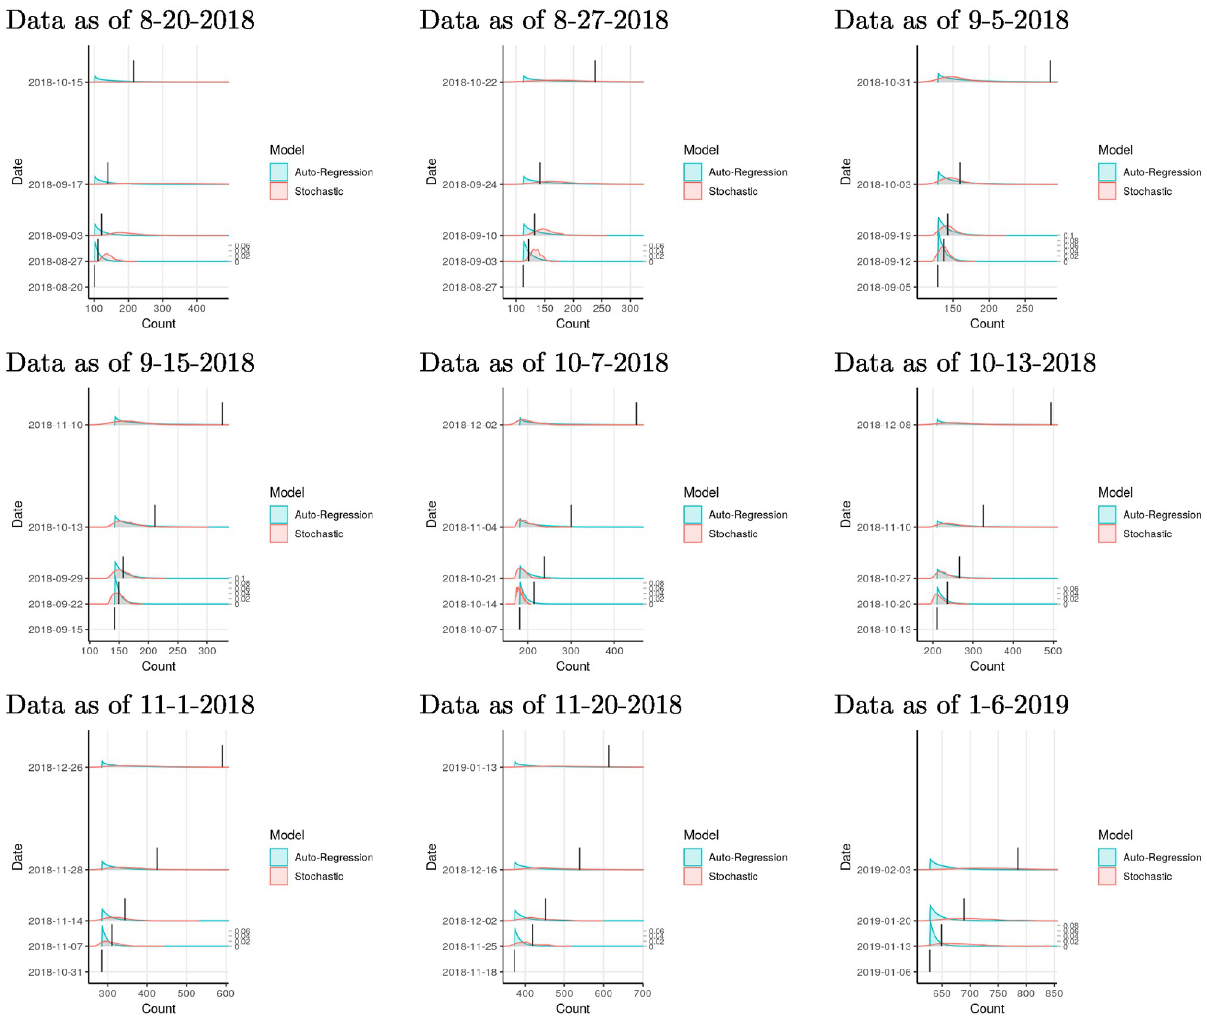
Fig 2. Prospective validation of probabilistic projections of auto-regression and stochastic models, by comparing projected cumulative case counts from past data to known case counts. Vertical bars indicate known case counts (height not to scale).